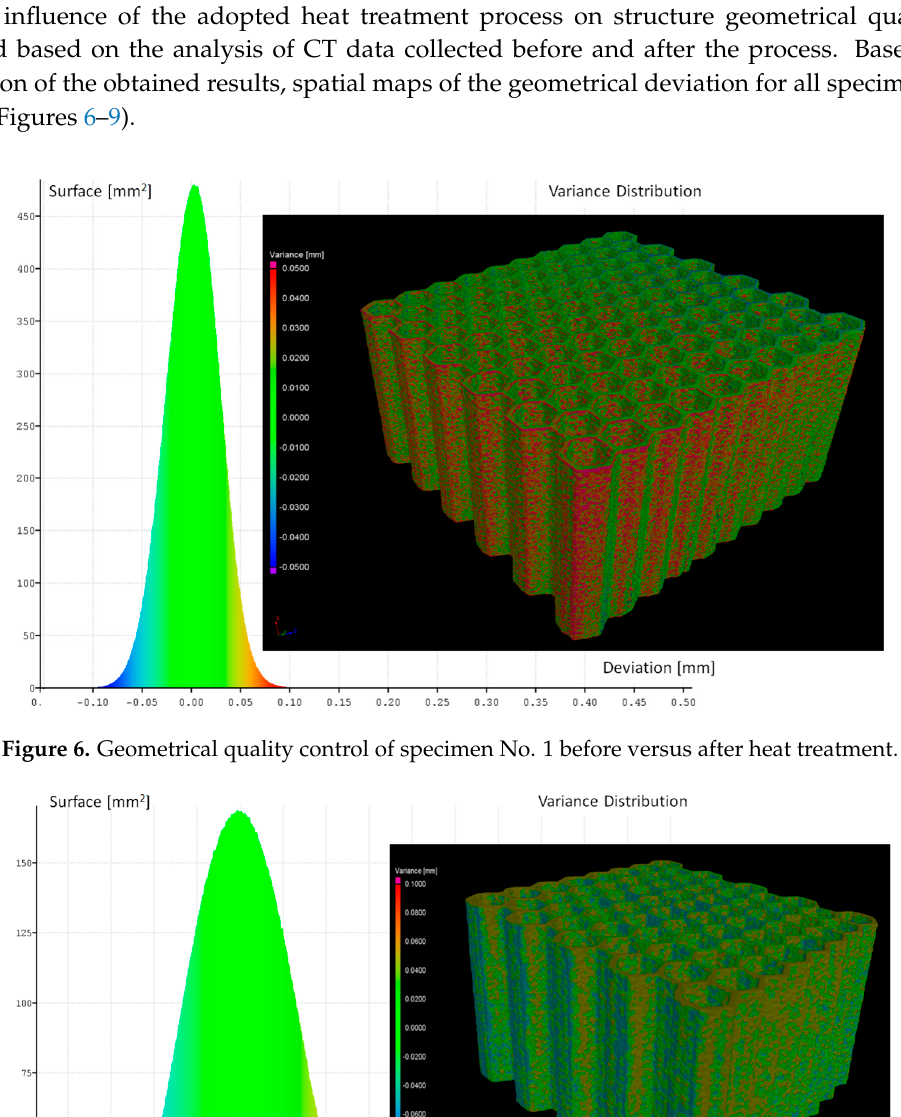
Figure 8. Geometrical quality control of specimen No. 3 before verses after heat treatment.